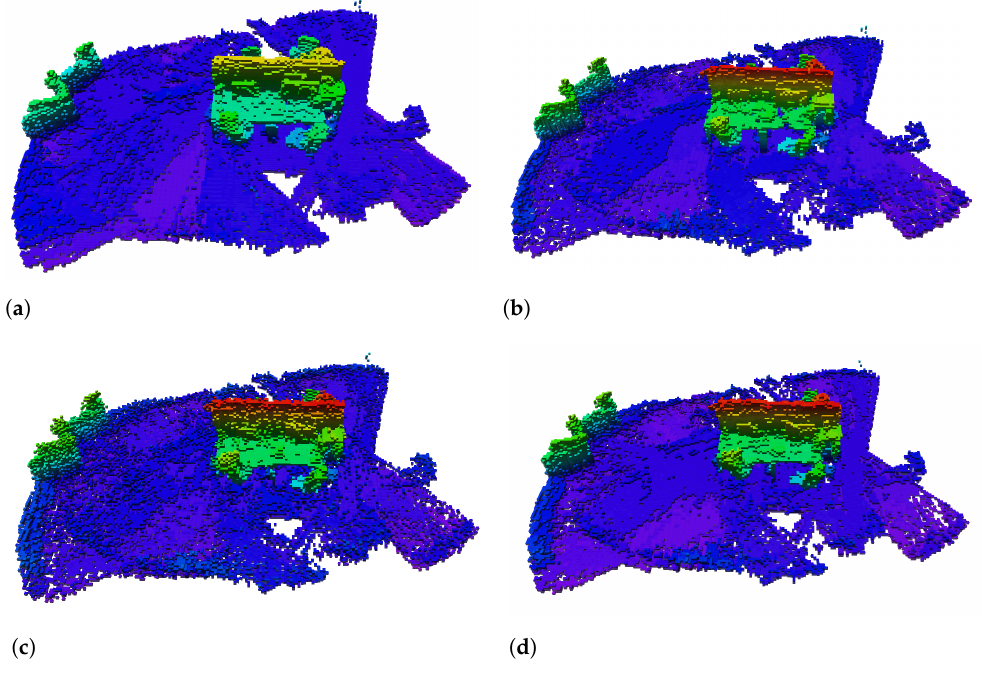
Figure 10. Benchmark outputs at 0.05 m grid resolution. ( a ) OctoMap. ( b ) Nanomap No Filter. ( c ) Nanomap Filter Modes 0 and 1. ( d ) Nanomap Filter Modes 2 and